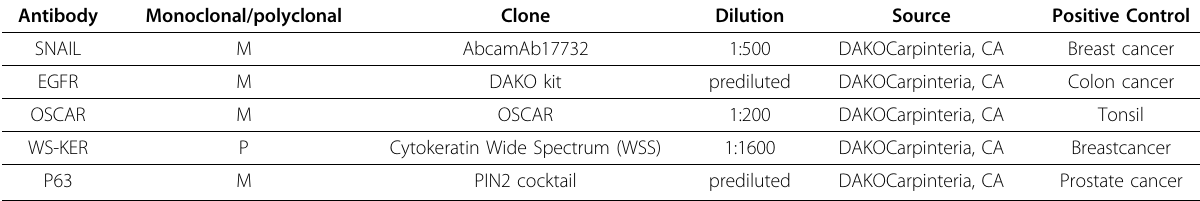
Table 2 Immunohistochemical stains used, including their clones, dilutions, source and controls Antibody